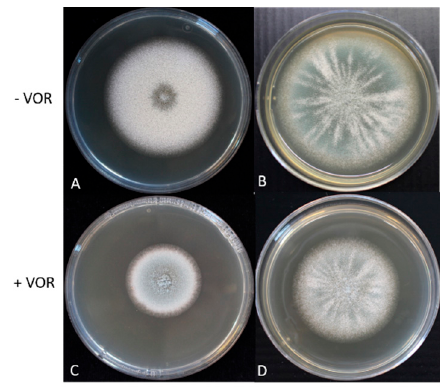
Figure 5. Competition between TR 34 /L98H (white conidia) and TR 343 /L98H (green conidia) in the absence (panel A ) and presence (panel C ) of VOR. Control between TR 343 /L98H (green conidia) and TR 34 3 /L98H (white conidia) in the absence (panel B ) and presence (panel D ) of VOR after two and half days of growth at 37 °C.